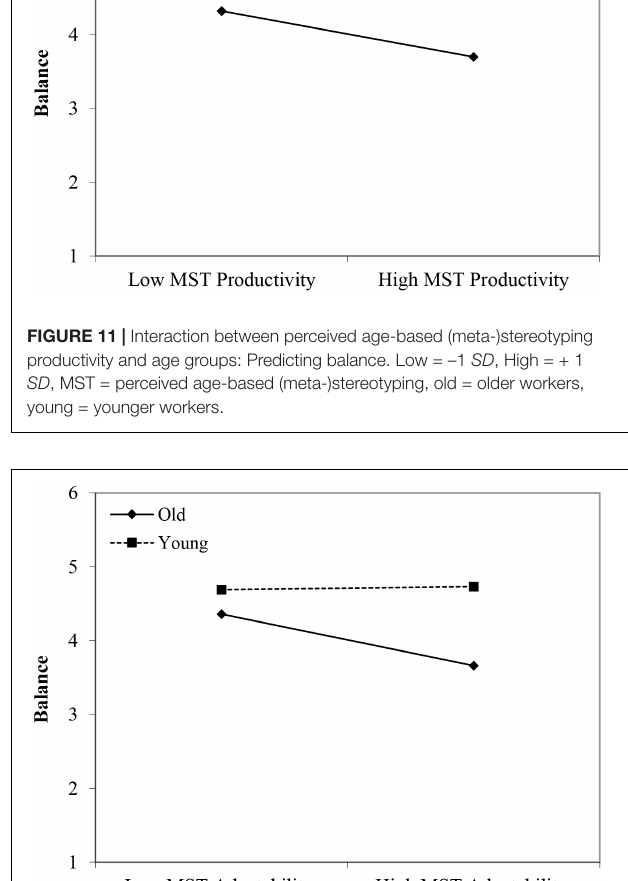
policies and practices is important (De Vos et al., 2016).